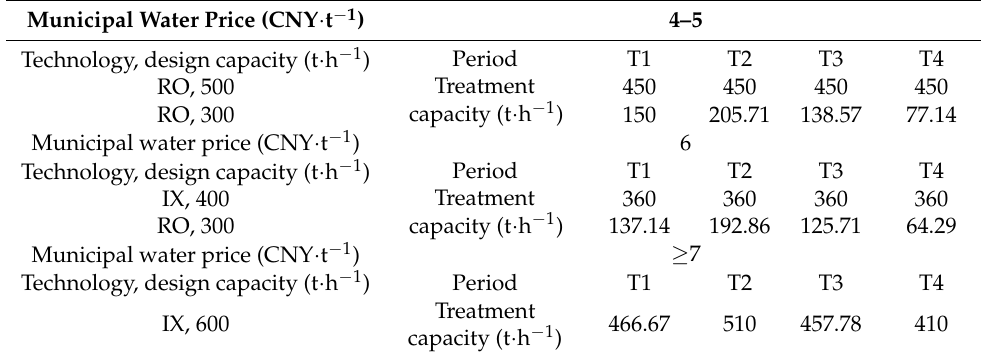
Table 7. Optimal operation scheme under different water price (Scenario